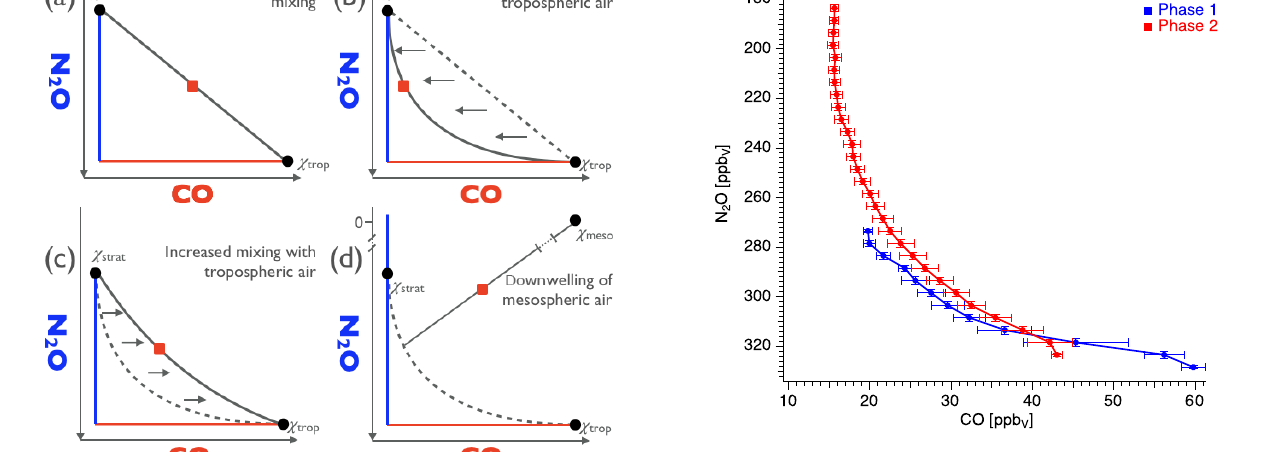
Figure 7. N 2 O–CO correlation for POLSTRACC flights with PV > 7PVU. The blue curve represents phase 1, the red curve rep- resents phase 2. Data are binned in steps of 5ppb V N 2 O. The vari- ability in each bin is given by the vertical and horizontal